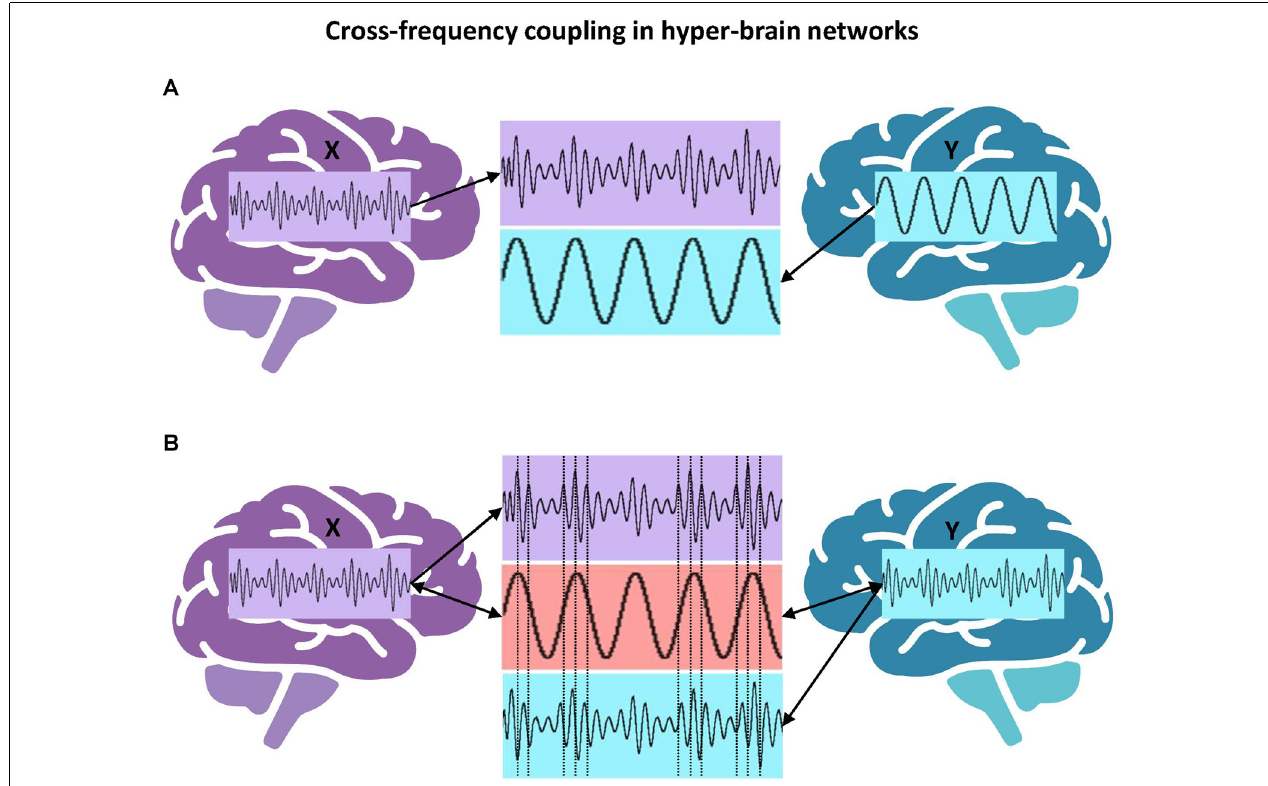
FIGURE 6 | Cross-frequency coupling in hyper-brain networks. (A) Hyper-brain theta-gamma phase-amplitude CFC, scenario 1. The amplitude or envelope of signal X in the brain on the left is coupled to the phase of signal Y in the brain on the right. (B) Hyper-brain theta-gamma phase-amplitude CFC, scenario 2. Signals X and Y (in the brains on the left and right, respectively) are gamma oscillations, which are mostly out of phase (indicated by the vertical dotted lines in the middle) but their amplitude or envelope is modulated by the common theta rhythm, which can be either endogenous or